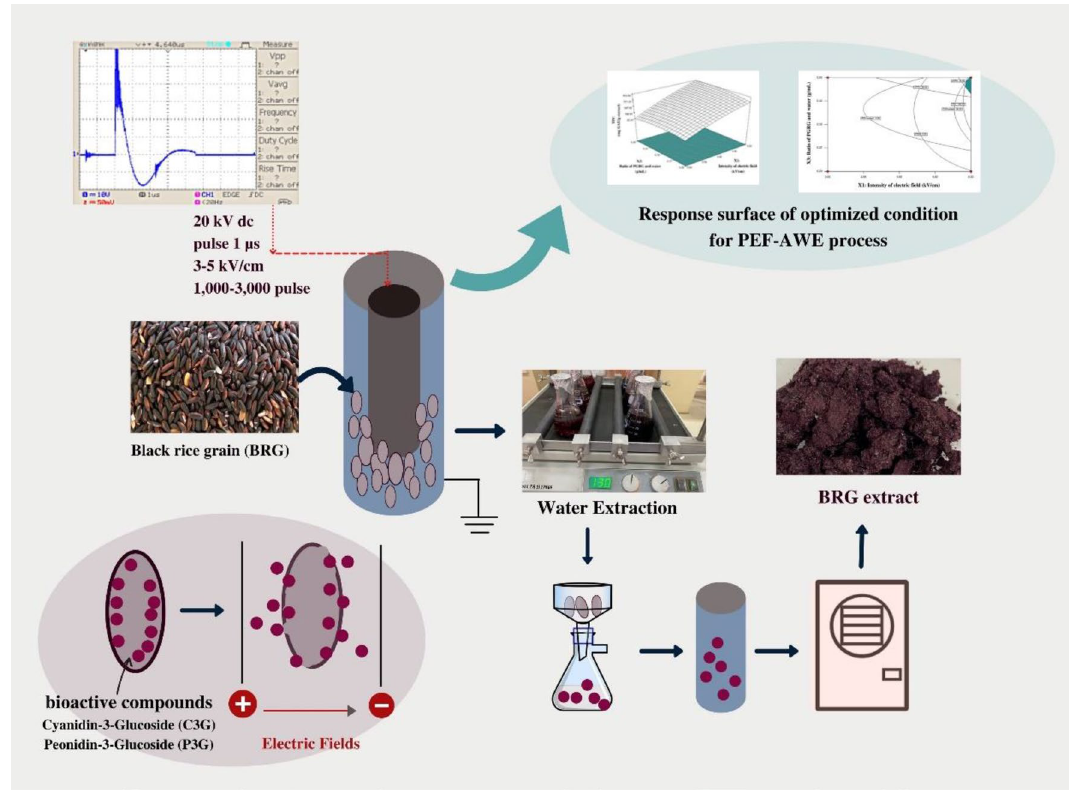
Figure 2. The process diagram of PEF-AWE. Independent